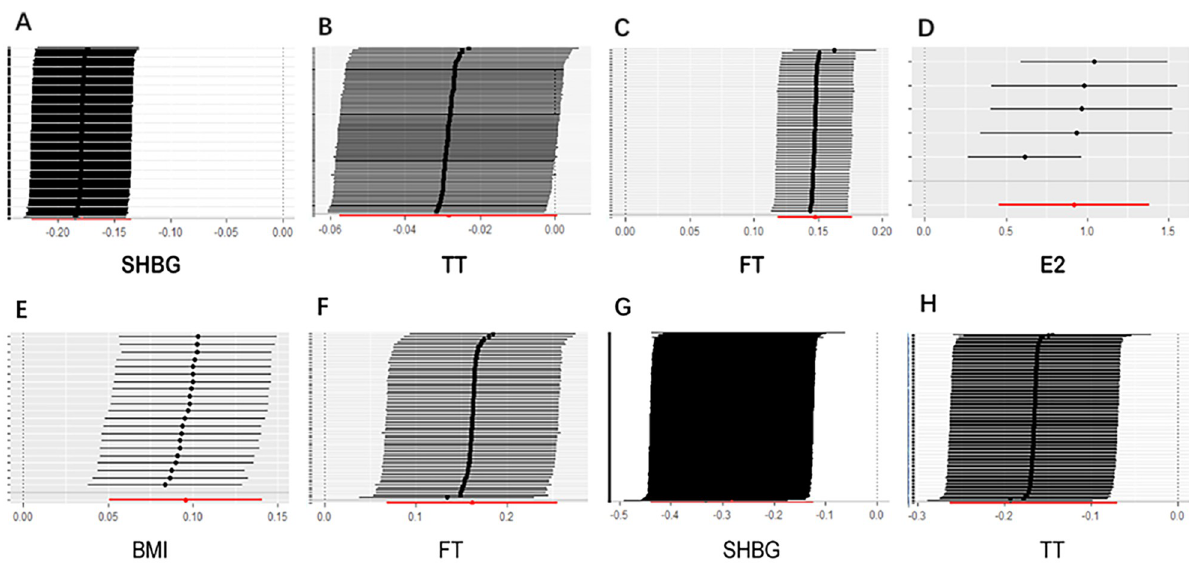
Fig 3. The leave-one-out method to verify the robustness of Mendelian randomization results. A-E are the leave-one-out results of SHBG, TT, FT, E2 and BMI from bone mineral density of heel bone respectively. F is the leave-one-out result of FT from bone mineral density of lumbar spine; G and H are the leave-one-out results of SHBG, TT from bone mineral density of forearm bone.